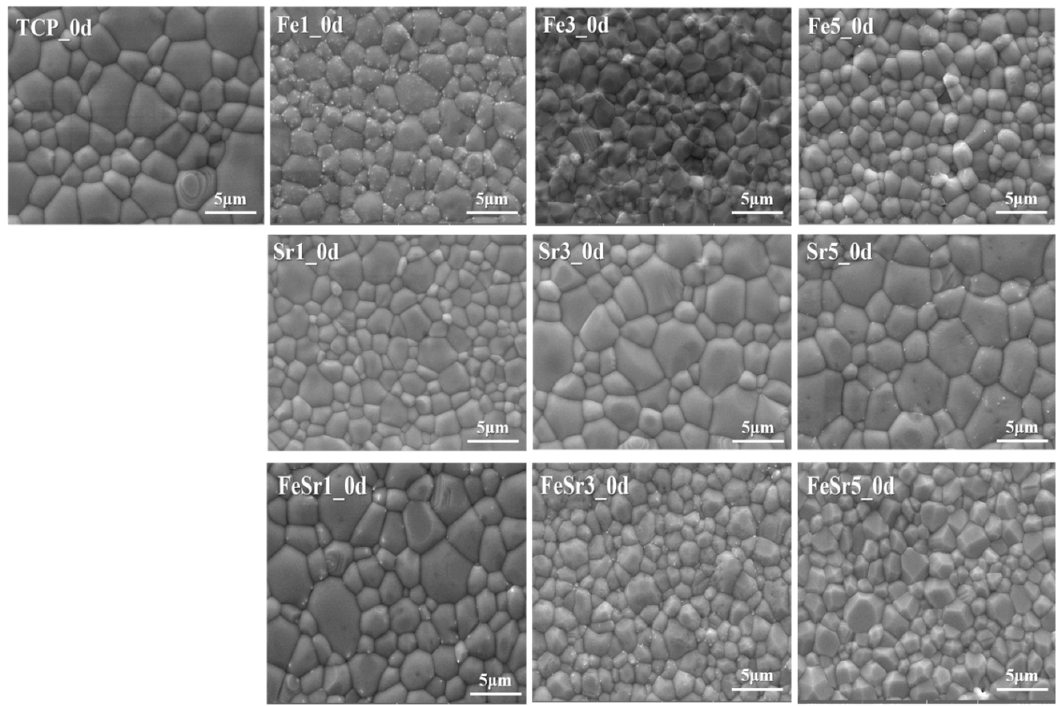
Figure 10. SEM images of various β -TCP discs sintered at 1100 °C. Table 4. Density of various β -TCP discs sintered at 1100 °C.